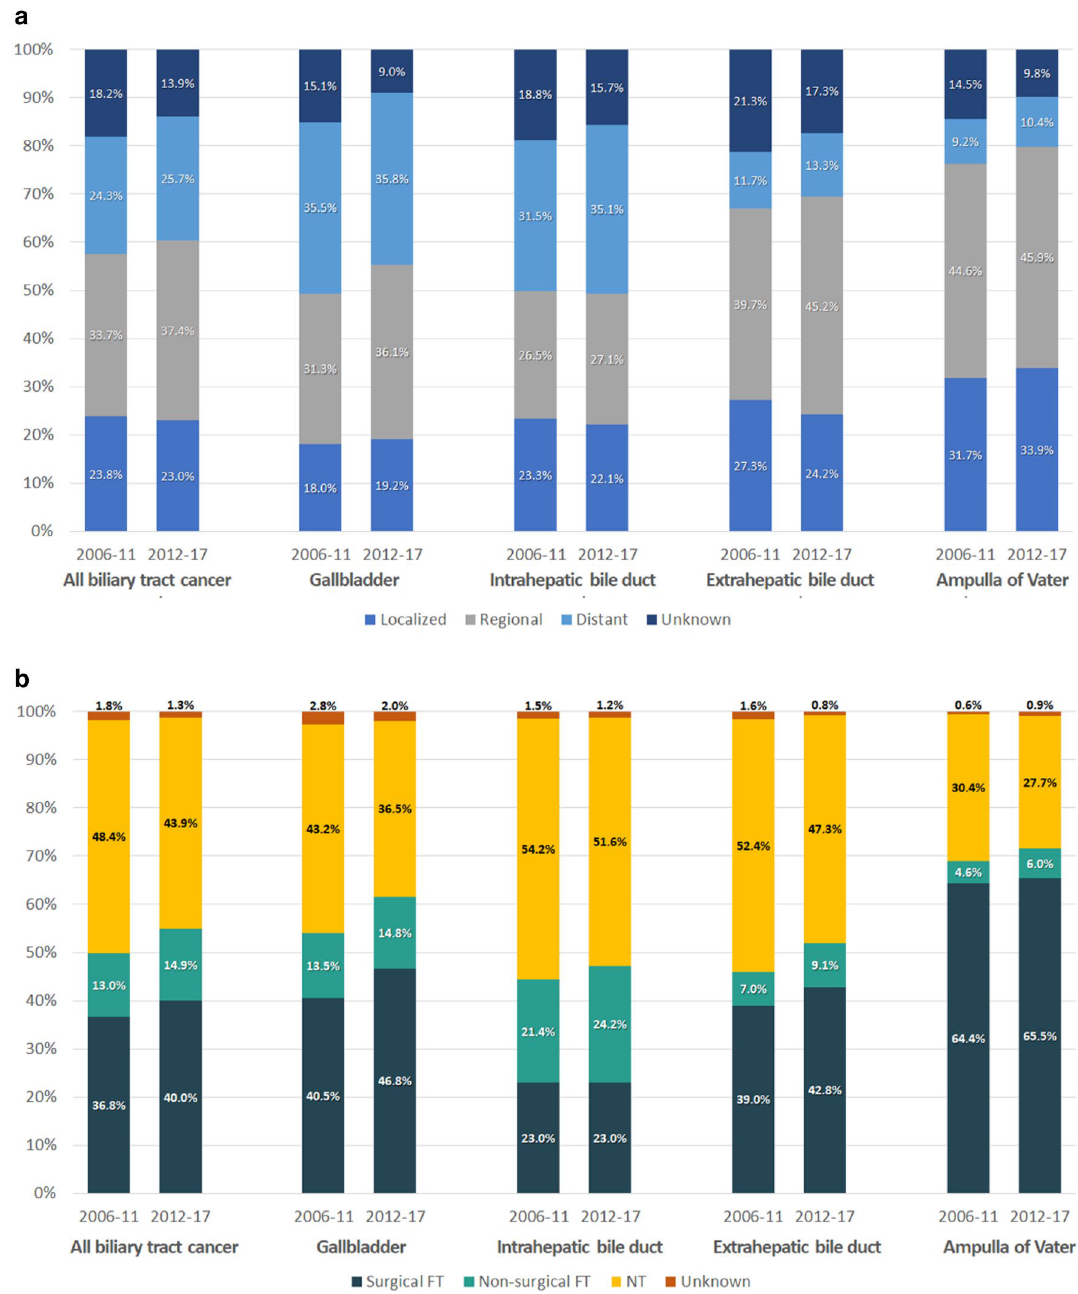
Figure 2. Change of SEER stage distribution and treatment pattern according to tumor location. ( a ) SEER stage distribution according to tumor location. ( b ) Treatment pattern according to tumor